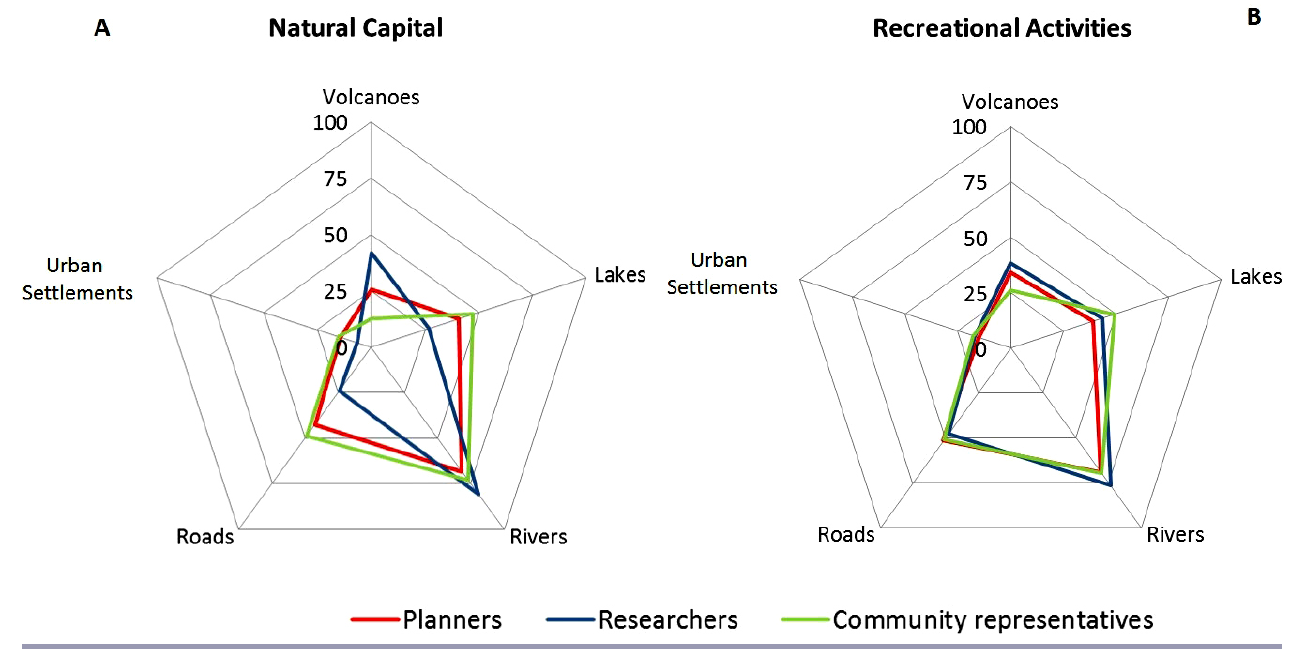
Fig. 3 . Elements of the natural and built environment influencing the placement of marks by the different groups of stakeholders (colored lines). The scale ranges from 0 to 100 according to the percentage of cells that fell within each rule, described in Table